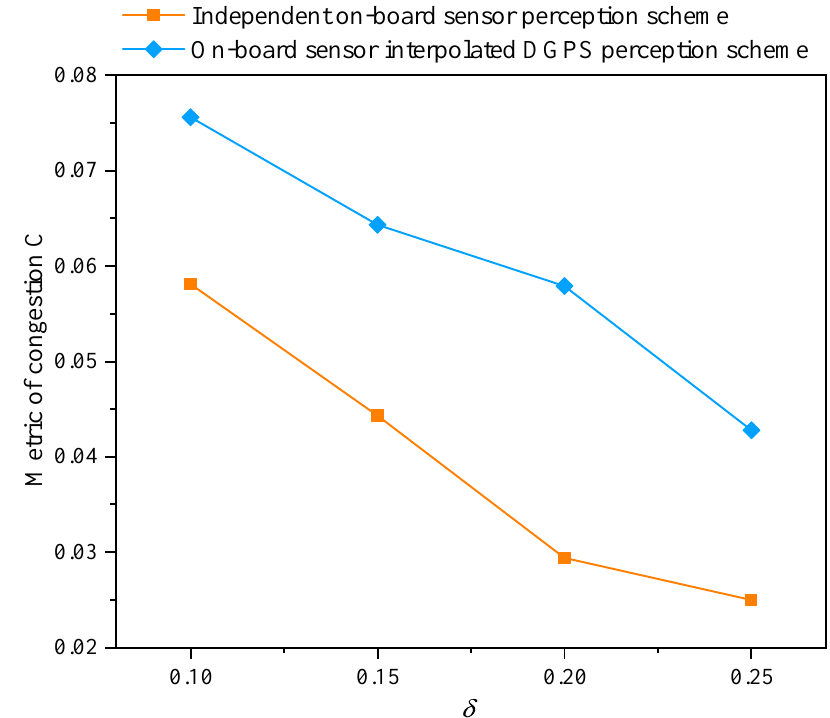
Figure 8. The metric of congestion for varying perceptual error size δ with an independent on- board sensor perception scheme and an on-board sensor interpolated DGPS perception scheme in a completely CAV